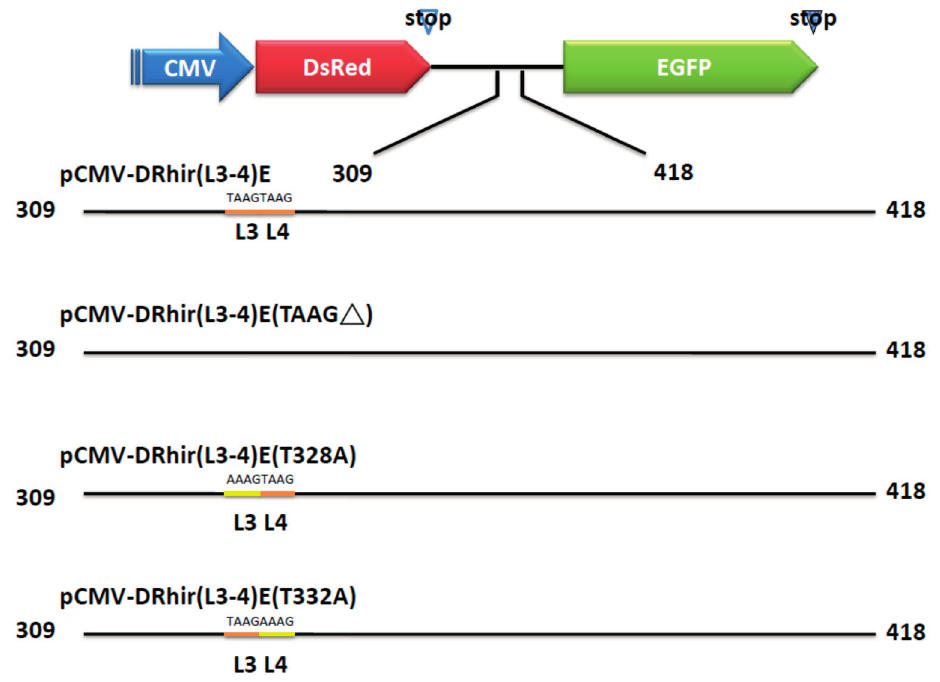
Figure 3. Schematic presentation of the truncations and mutations in the RP110 cryptic promoter. The indicated cDNA fragments were generated by chemical synthesis and inserted between the DsRed and EGFP genes in the bicistronic vector pCMV-DRhir(L3-4)E which containing the 309–418 bps of RhPV IRES cDNA fragment and the two tandem repeated TAAG motifs L3 and L4. pCMV-DRhir(L3-4)E (TAAG ∆ ) indicated the L3 and L4 TAAG were deleted. pCMV-DRhir(L3-4)E (T328A) denoted the 328th nucleotide T was change